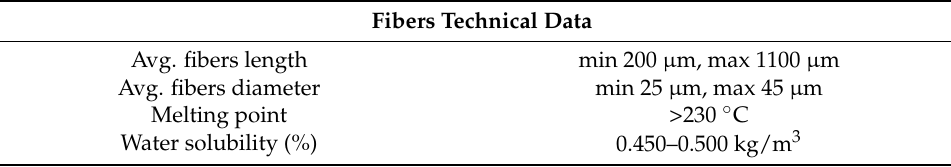
Table 1. Properties of cellulose stabilizing